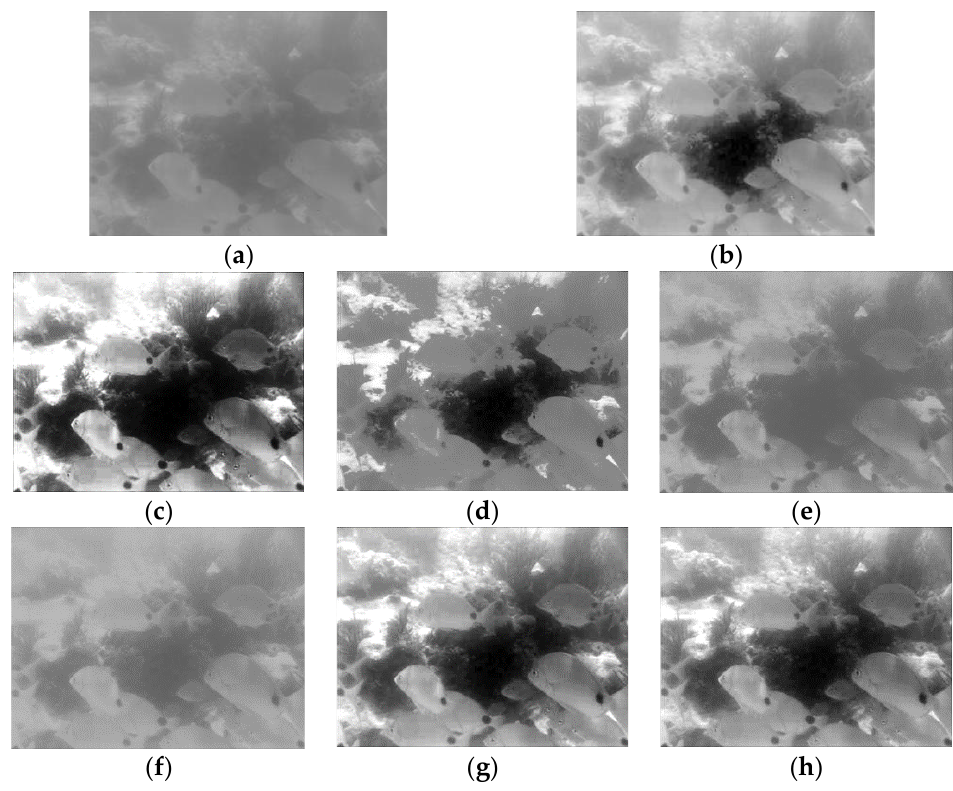
Figure 10. Images of “ fish ” enhanced with several algorithms: ( a ) original image, “ fish ” ; ( b ) Ref. [30]; ( c ) BHEMHE; ( d ) RMSHE; ( e ) DSIHE; ( f ) AGCWD; ( g ) BHEPL; ( h ) proposed method. Table 3. Experimental data for the medium grayscale image “ fish ” .